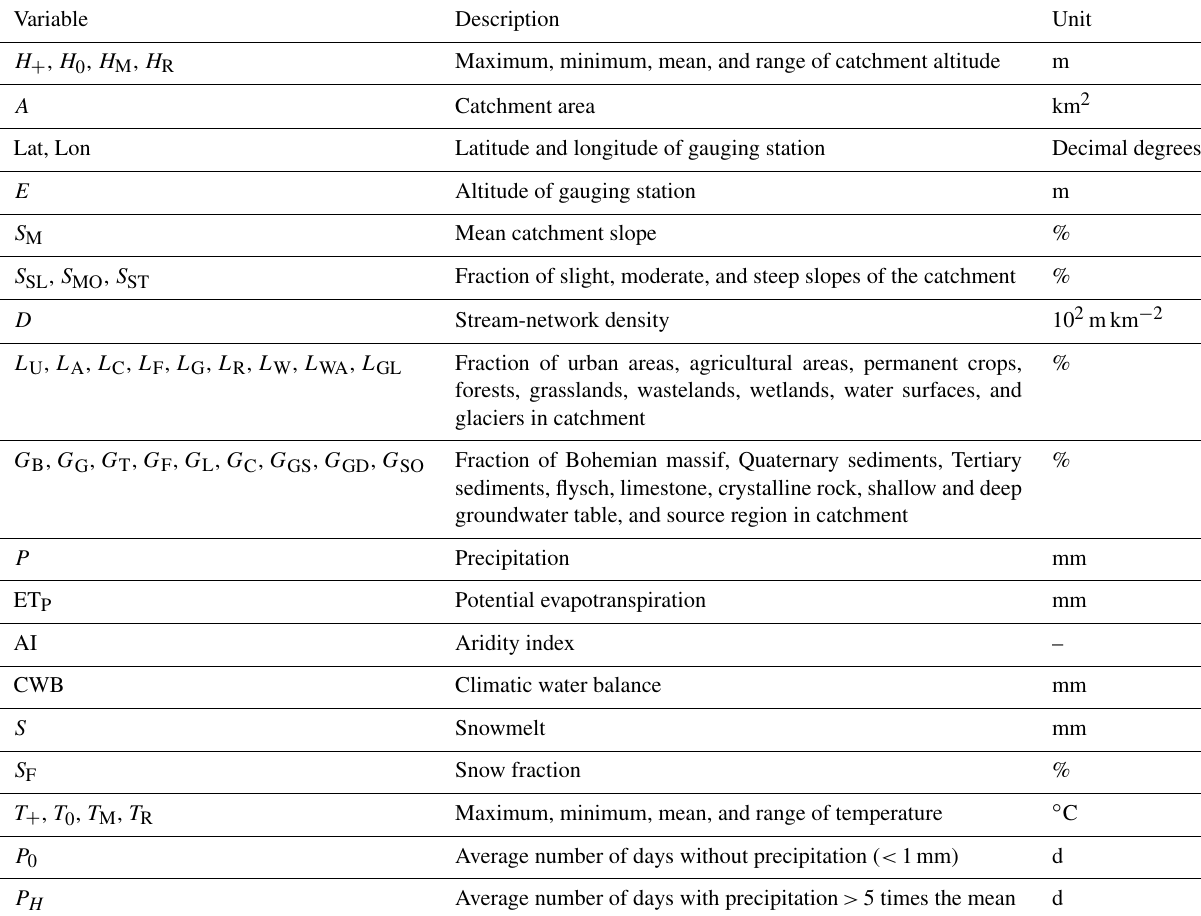
Table 1. Descriptions of the catchment characteristics that are used in the study. Abbreviations are further used in plots. Precipitation, climatic water balance, potential evapotranspiration, aridity index, snowmelt, snow fraction, and temperature variables are used on an annual, seasonal, and half-year basis. These different accumulation periods are indicated by an extension of the indices (annual, spring, summer, autumn, winter, winter, hy and summer,